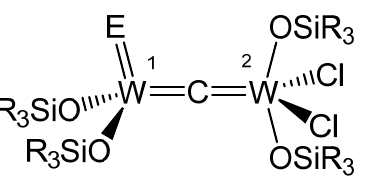
Figure 38. Structural representation of the W carbido complexes ( t Bu 3 SiO) 2 (NR)W=C=WCl 2 (OSi t Bu 3 ) 2 and ( t Bu 3 SiO) 2 (O)W=C=WCl 2 (OSi t Bu 3 ) 2 .